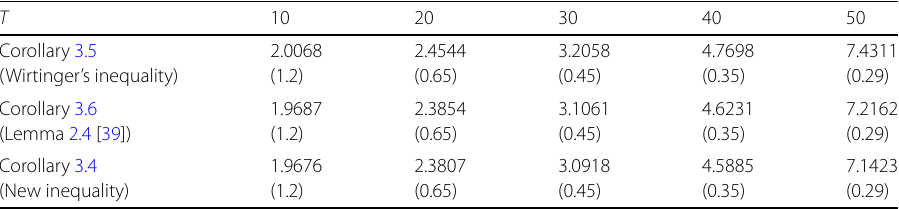
Table 5 MALBs of c 2 for different values of T in Example 4.2 (Case I). Numbers in parentheses are (cid:9) T 10 20 30 40 50 Corollary